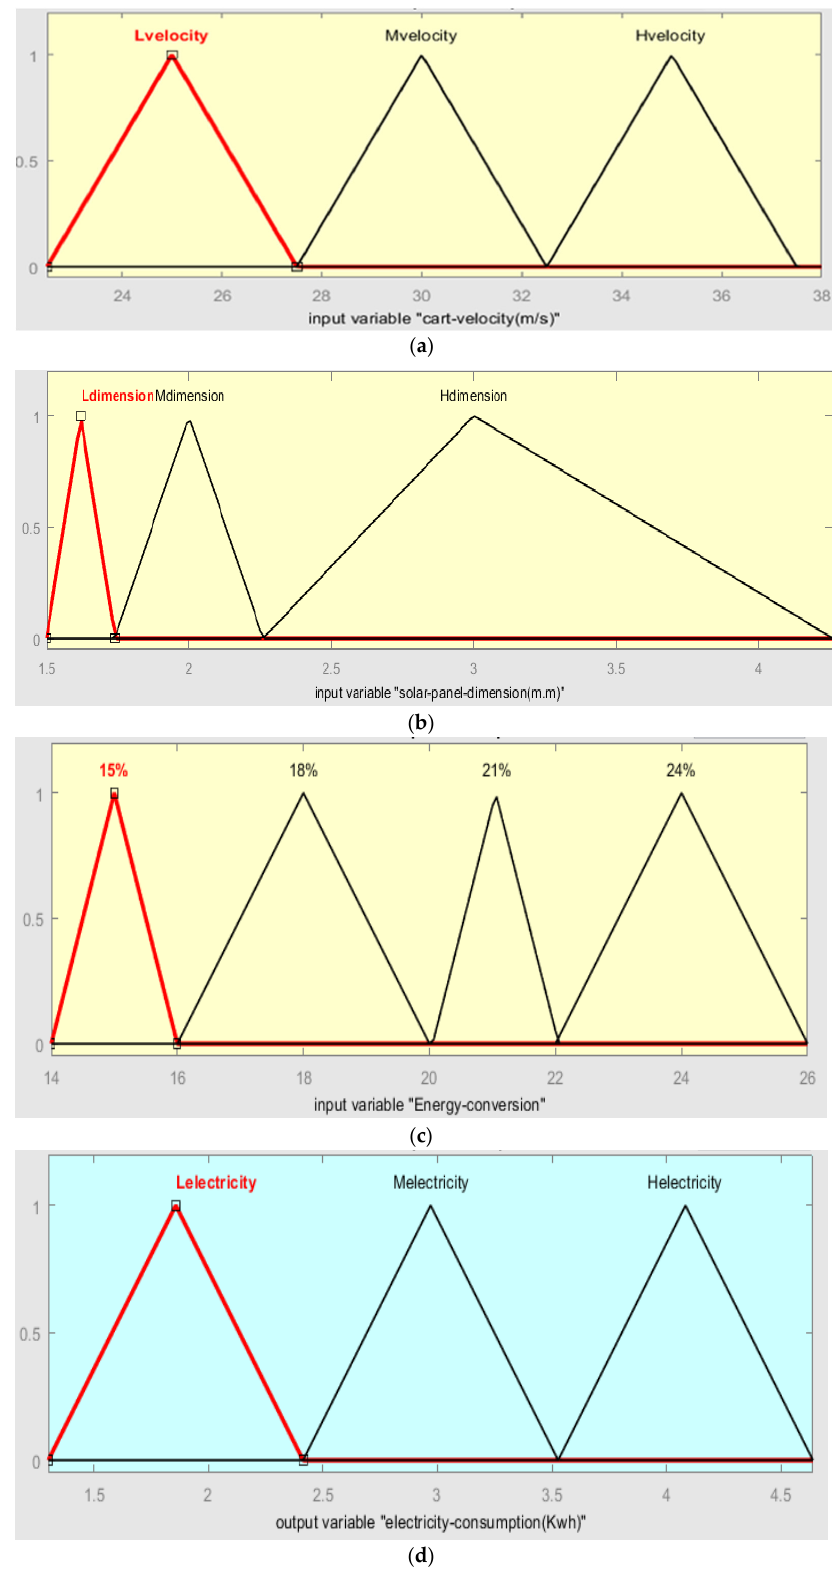
Figure 5. Low, medium, and high values for inputs ( a – c ) and output ( d ).